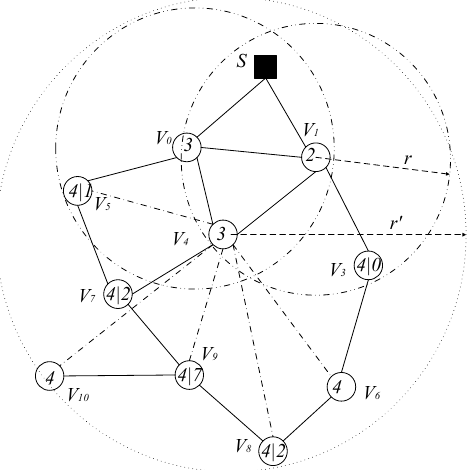
Figure 8. The network topology and slot status after increasing active and increasing radius.